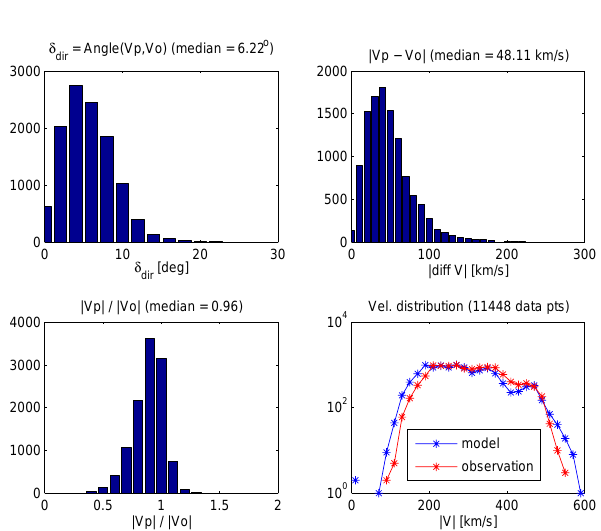
Fig. 7. Comparison of the predicted flow velocity with THEMIS P1 and P2 observations. The content of the panels is analogous to Fig.